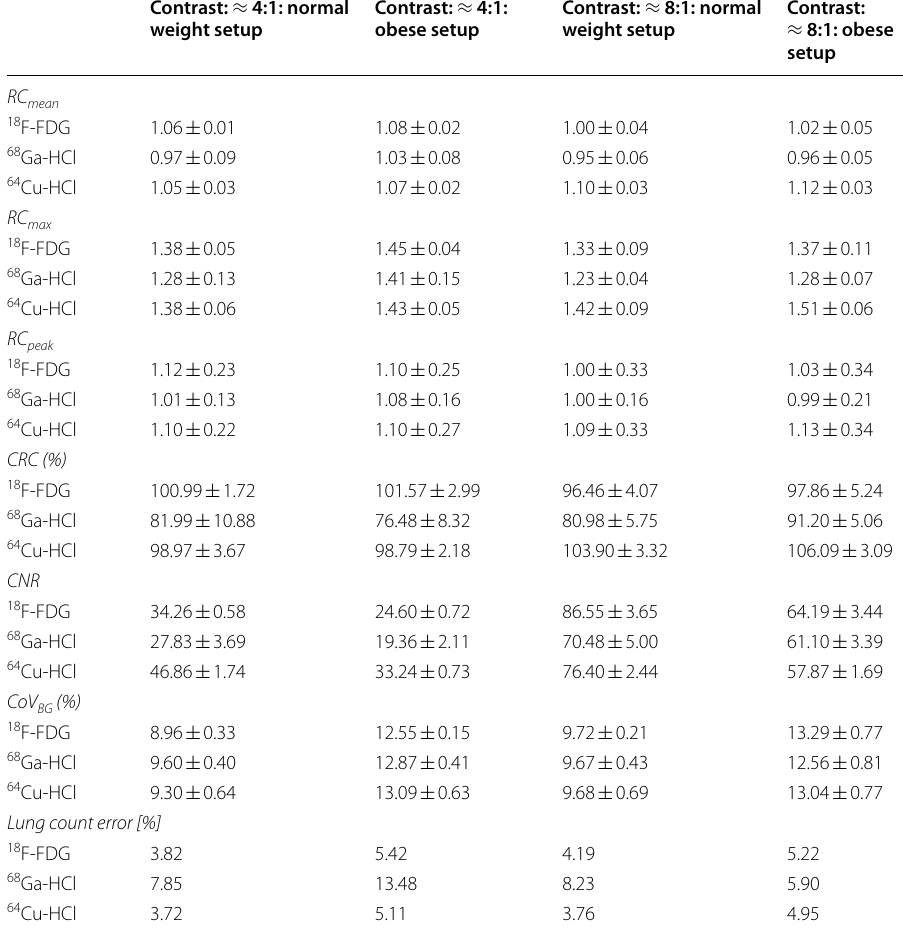
Table 4 Means and standard deviations of image quality parameters determined for NEMA PET body phantom